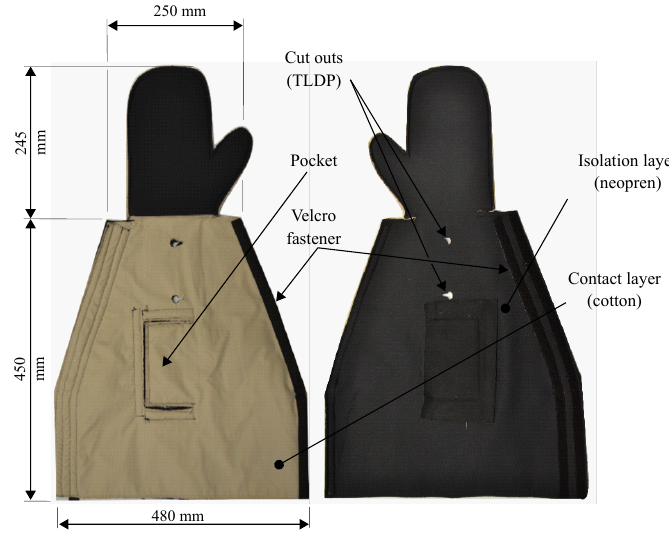
Figure 7. Design prototype of the function-integrative